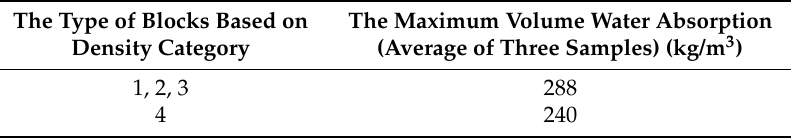
Table 12. Water absorption of concrete blocks in accordance with ISO 7782